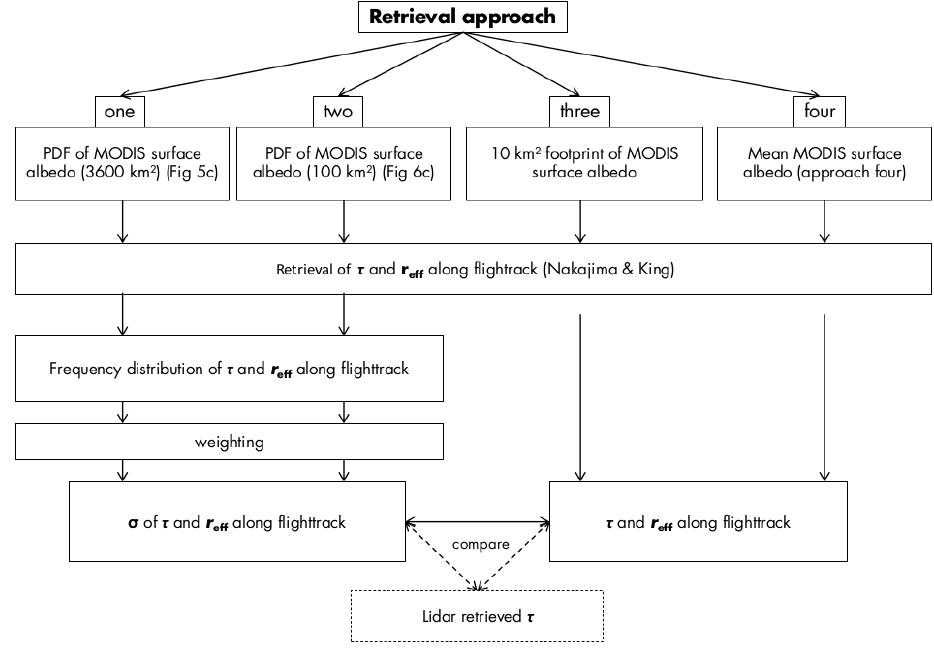
Fig. 10. Schematic sketch illustrating the different retrieval approaches quantifying the influence of surface albedo variabilities.